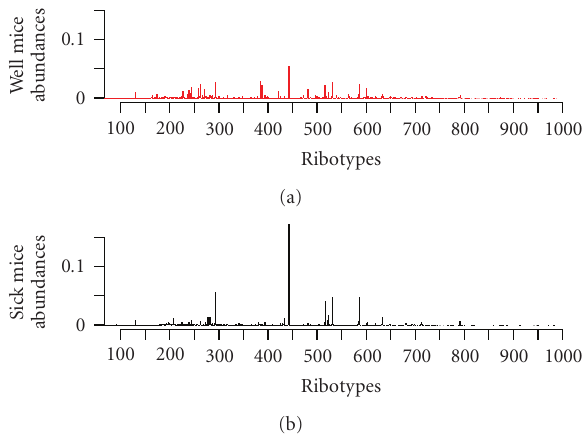
Figure 7: ARISA analysis of DNA from cecal contents of 129 N5 DKO mice stratified by the disease severity. Seven of 18DKO mice on LabDiet, 13 of 14 DKO mice on AIN diet, and 9 of 16DKO mice on AIN diet with daily contact of soiled bedding from LabDiet group were combined in the well group (29 mice) based on pathology. The other 19 DKO mice were stratified in the sick group. The median colon pathology score for well mice was 3 (range of 0–5) and 6 for sick mice (range of